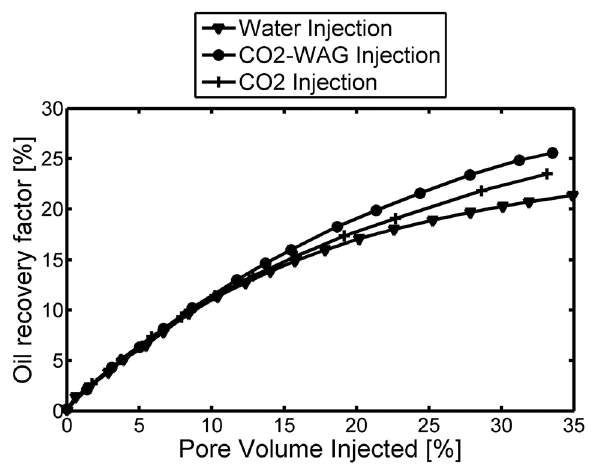
Fig. 16 Oil fraction recovered versus pore volume